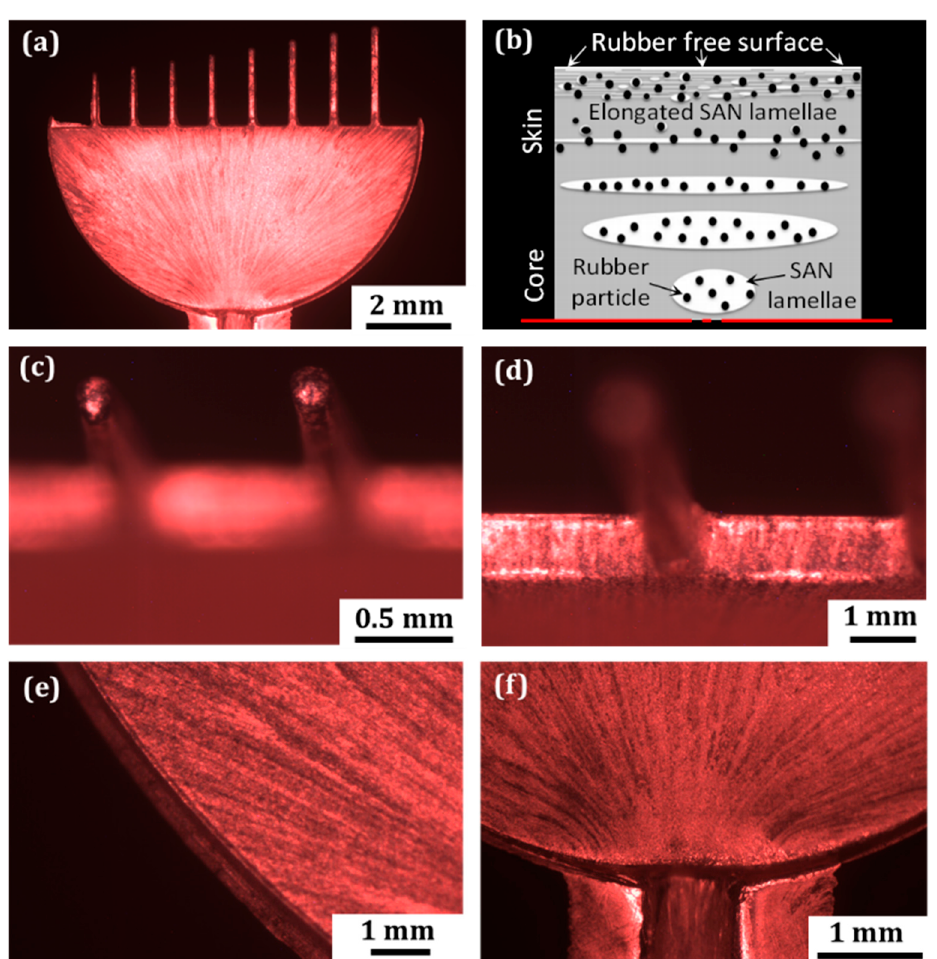
Figure 4. Poor quality of metallization on PC-ABS micropart ( a ); morphology of molded PC-ABS negatively affecting the metallization quality (( b ) edited from [21]); low effectiveness of the metallization on PC-ABS microfeatures: on the smallest fingertips ( c ); on the internal corners ( d ); on semicylinder edge ( e ); and on the gate system ( f ).